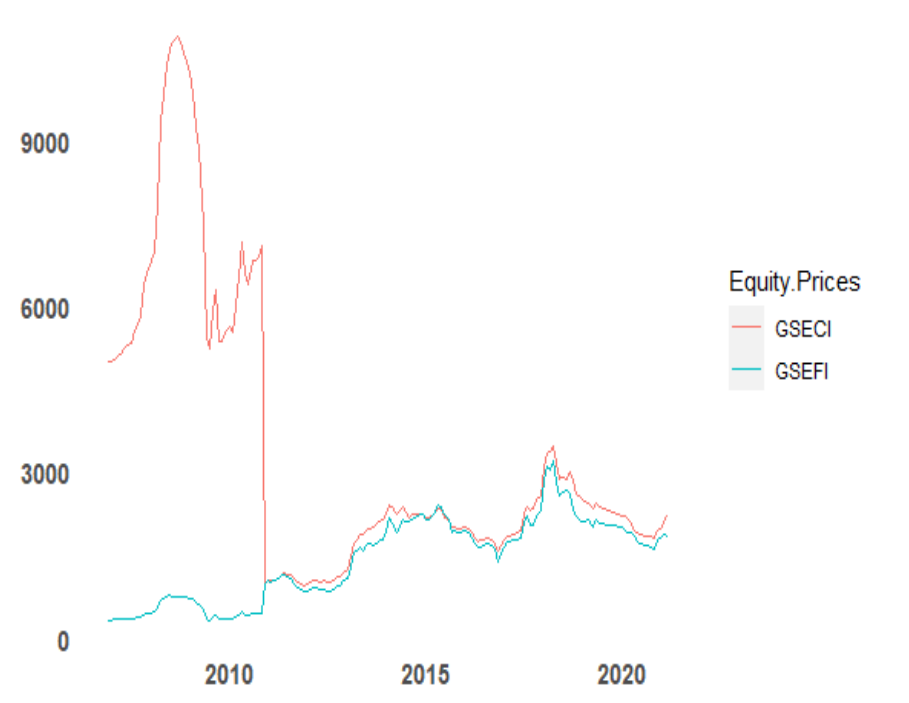
Figure 1. Combined plots of both GSEFI and GSECI from January 2007 to March 2021.